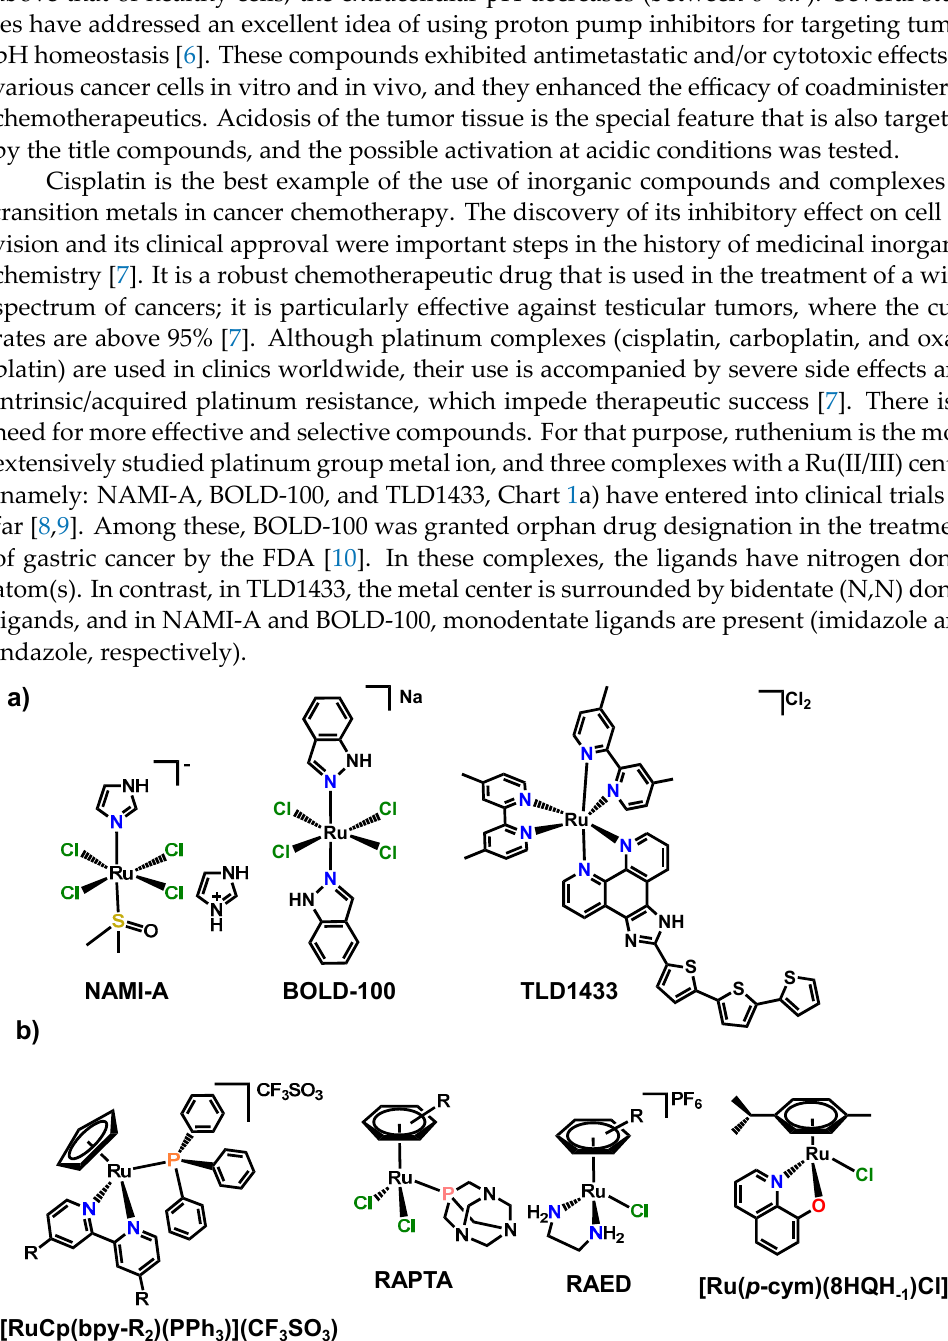
Chart 1. Structures of ( a ) octahedral and ( b ) half‑sandwich Ru complexes with promising anticancer activity.